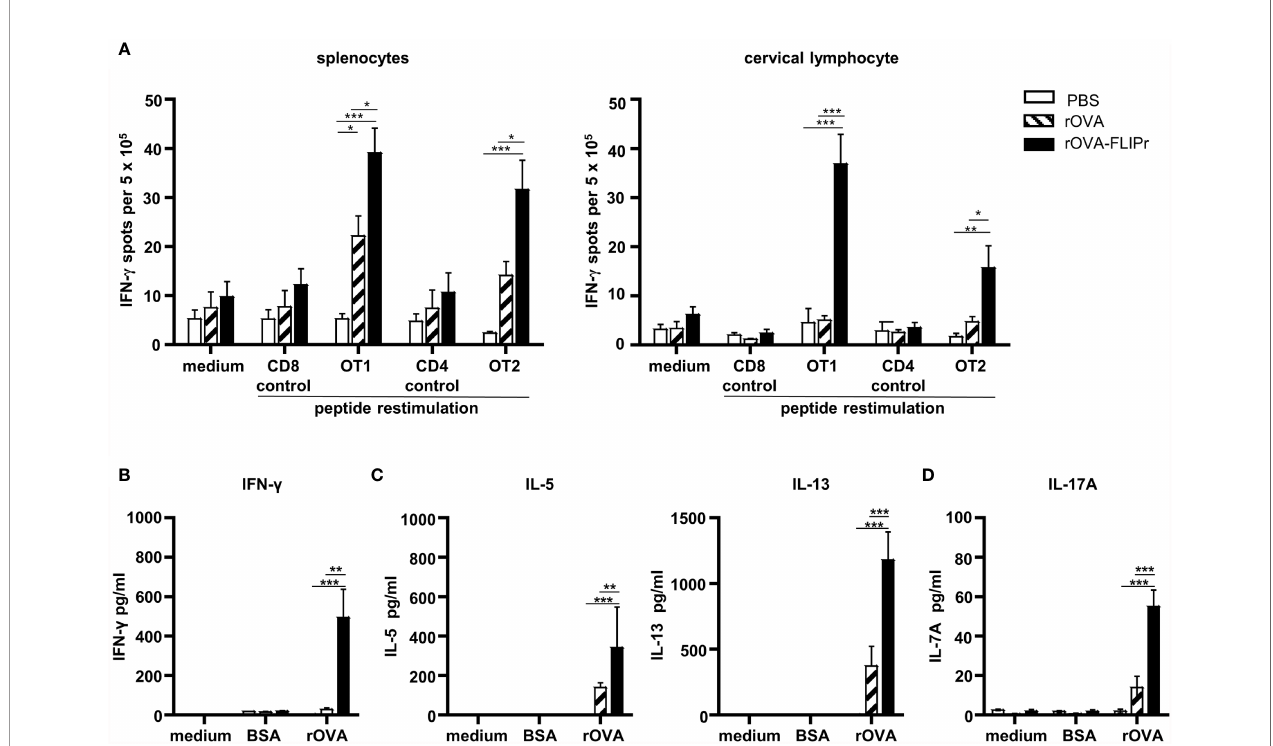
FIGURE 4 | T cell responses and cytokine production pro fi les induced by intranasal administration of rOVA-FLIPr. Groups of C57BL/6 mice (n=5/group) were immunized three times intranasally with 30 m g of OVA or OVA-FLIPr in PBS at 2-week intervals. Mice immunized with PBS alone (without antigens) served as controls. (A) Splenocytes and cervical lymphocytes were harvested one week after the last immunization. Cells were cultured and stimulated with OT1, OT2, or control peptides for 3 days in an anti-INF- g -coated 96-well ELISPOT plate. IFN- g responses were measured using ELISPOT assay and are expressed as spot- forming units per 5×10 5 cells. (B – D) Splenocytes were cultured and stimulated with rOVA for 4 days. Stimulation with BSA or medium alone served as controls. The supernatants were collected to evaluate levels of (B) IFN- g , (C) IL-5, IL-13 and (D) IL-17A by ELISA. Data represent the mean ± SE of the mean. The results shown are from one of two representative experiments. Statistical signi fi cance was determined using the Kruskal-Wallis test with Dunn ’ s multiple comparison test. *p<0.05; **p<0.01; ***